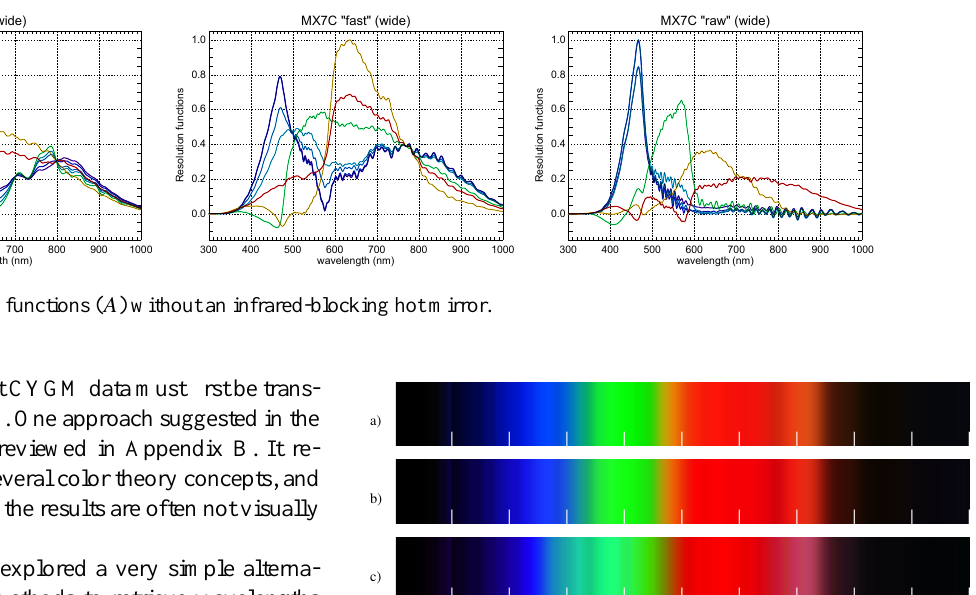
The RGB contribution matrix for the MX7C fast mode is given in Equation 19. There is a similar scaledifferencereflectinggreaterCCDsensitivitytoredwavelengths,butthematrixisnon-diagonal due to the more complex relationship between device channels and the primary colors.